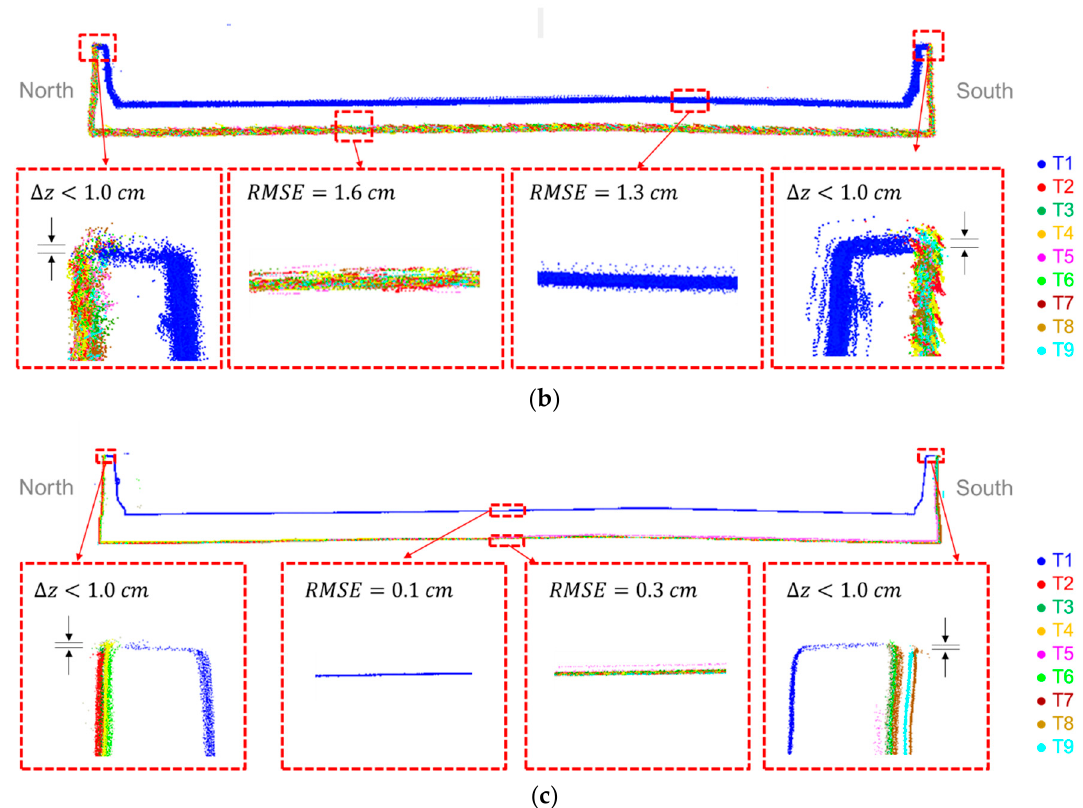
Figure 17. Sample cross-sectional profile showing the post-registration point cloud alignment for the ( a ) TLS, ( b ) PWMMS- HA, and ( c ) PWMMS-UHA datasets.